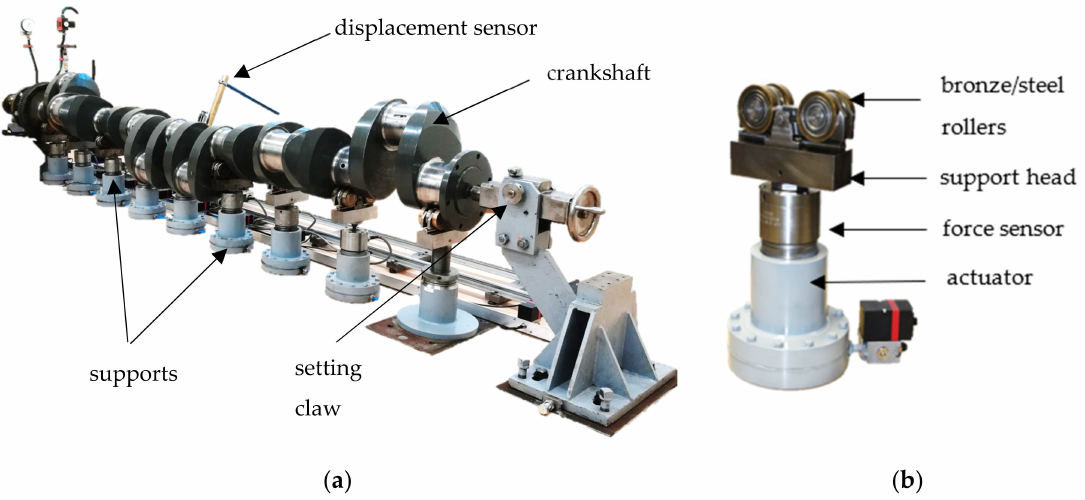
Figure 1. Measuring system ( a ) with elastic support of the crankshaft ( b